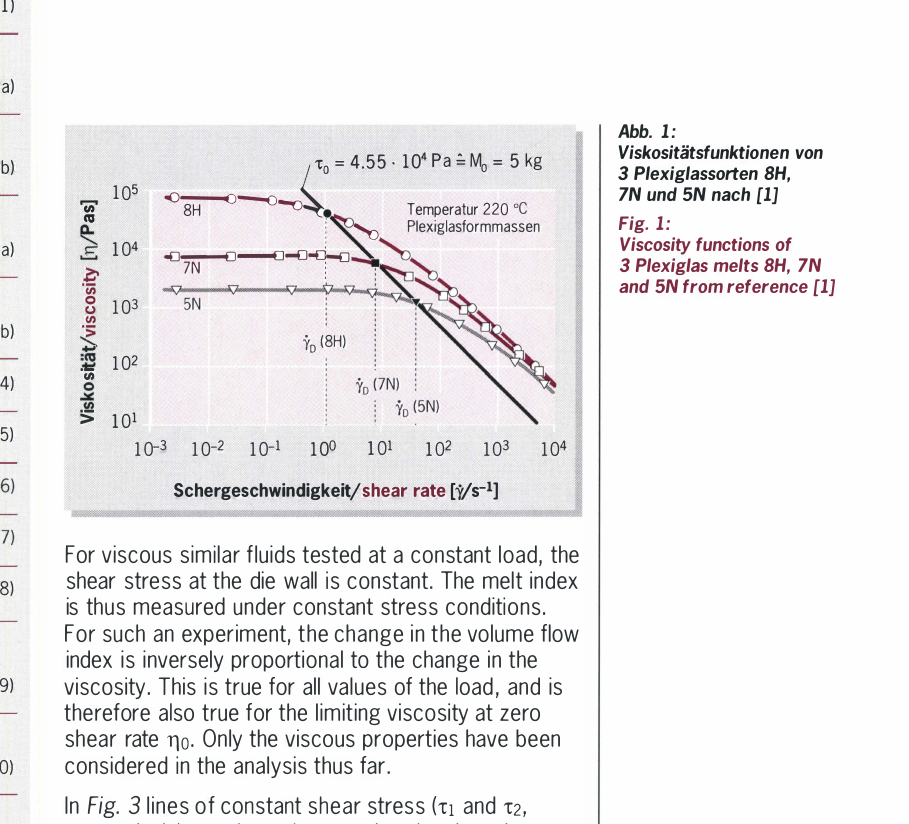
Fig. 1: Viscosity functions